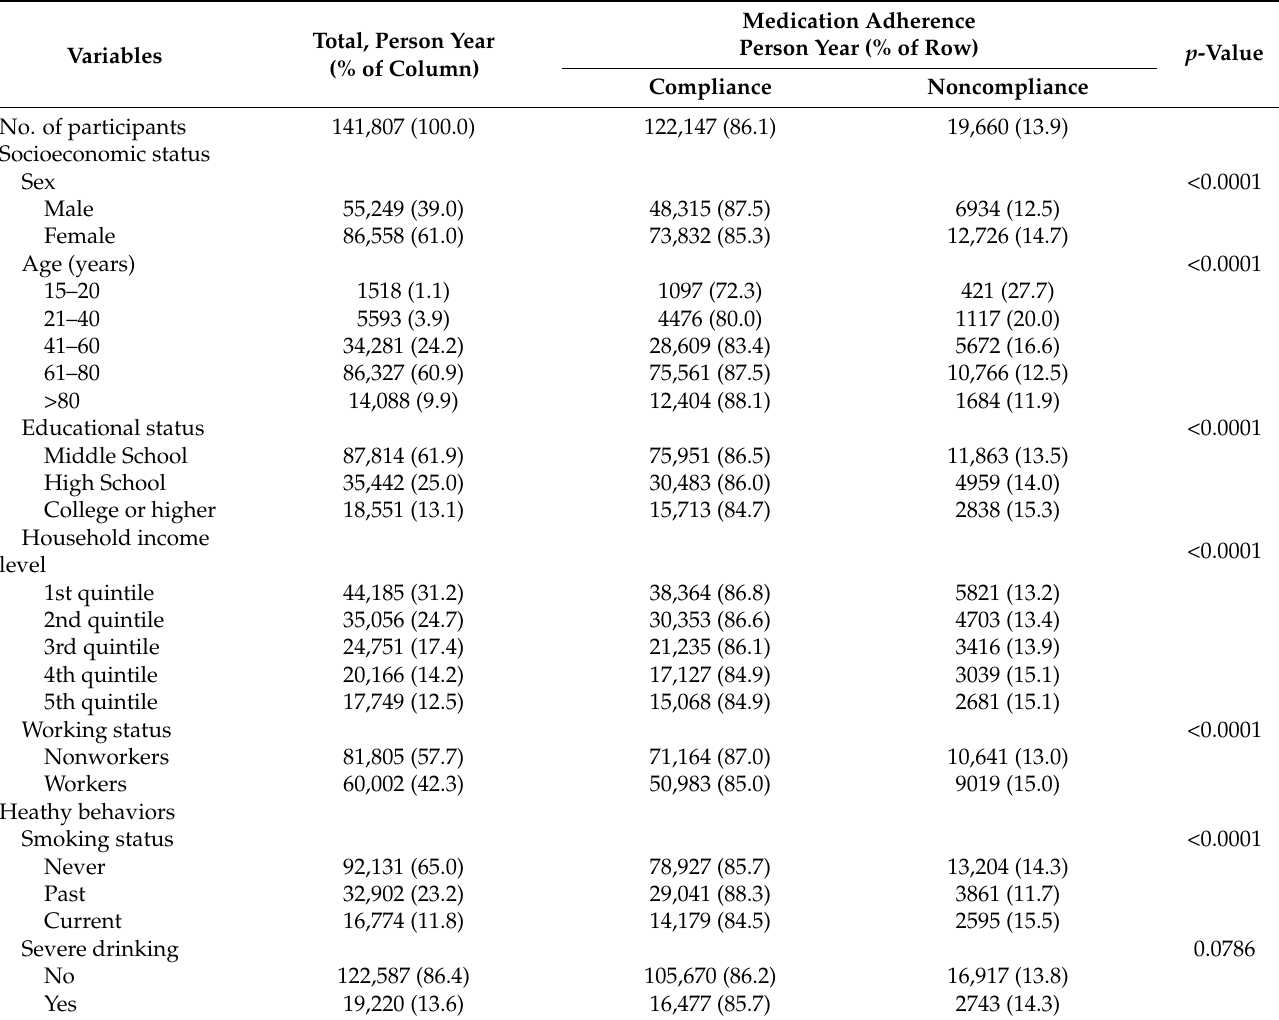
Table 1. General characteristics of the study participants with metabolic diseases according to medication adherence during the follow-up